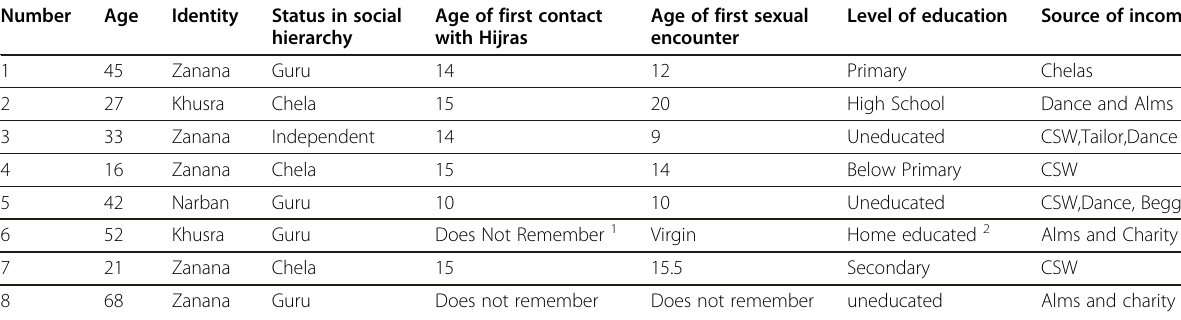
Table 1 Profiles respondents of In-depth